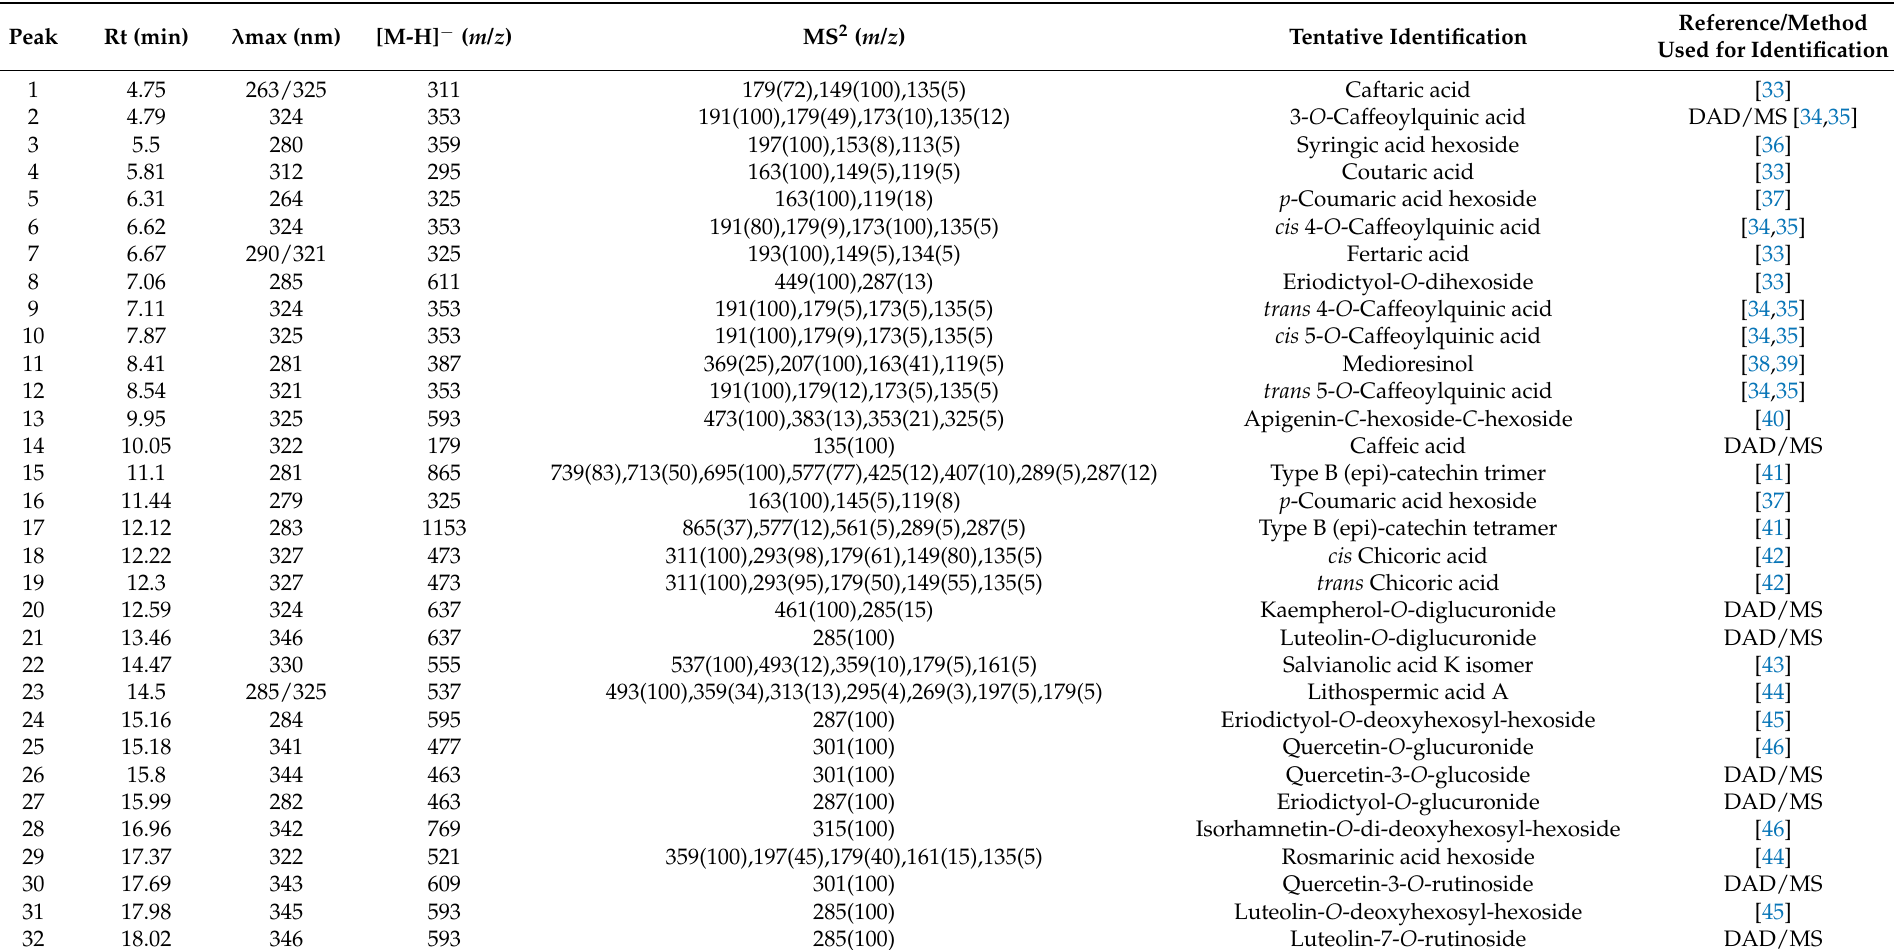
Table 2. Retention time (Rt), wavelengths of maximum absorption in the visible region ( λ max ), mass spectral data, and tentative identification of phenolic and non-phenolic compounds found in the tisanes prepared from five MAP mixtures (T1, T2, T3, T4, and T5).